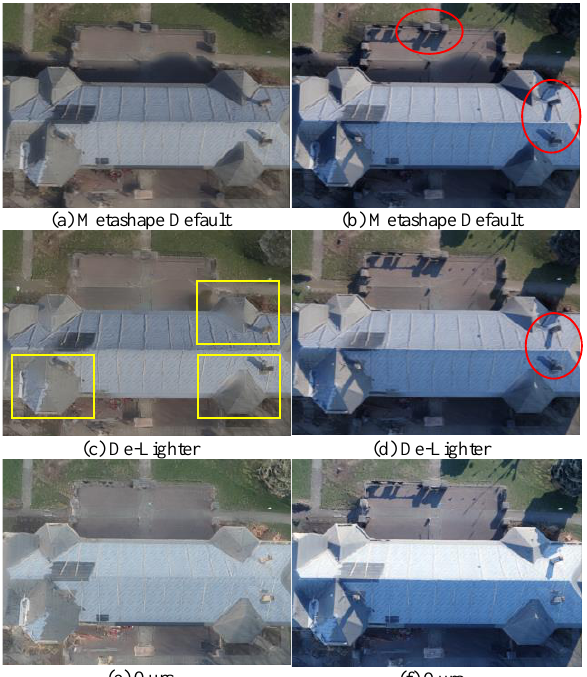
Figure 13. Uniform lighting (left column) and sun-sky relighting (right column). From top to bottom: (a) and (b) standard pipeline; (c) and (d) De-Lighter; (e) and (f) ours.